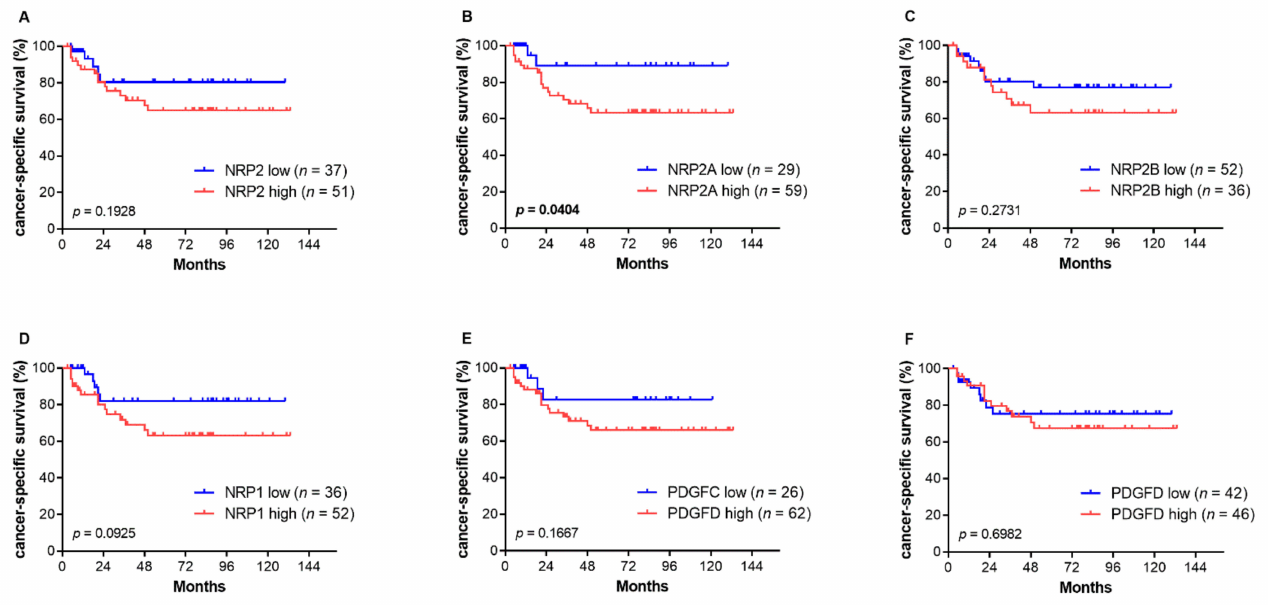
Figure 6. Kaplan–Meier curves of cancer-specific survival (CSS) stratified by mRNA expression of NRP2 and its transcripts ( A – C ), NRP1 ( D ) and PDGFC ( E ) and PDGFD ( F ). The cut-off values for high and low gene expressions were determined by a partition test with each group representing at least 20% of the total cohort. Significant p values are printed in